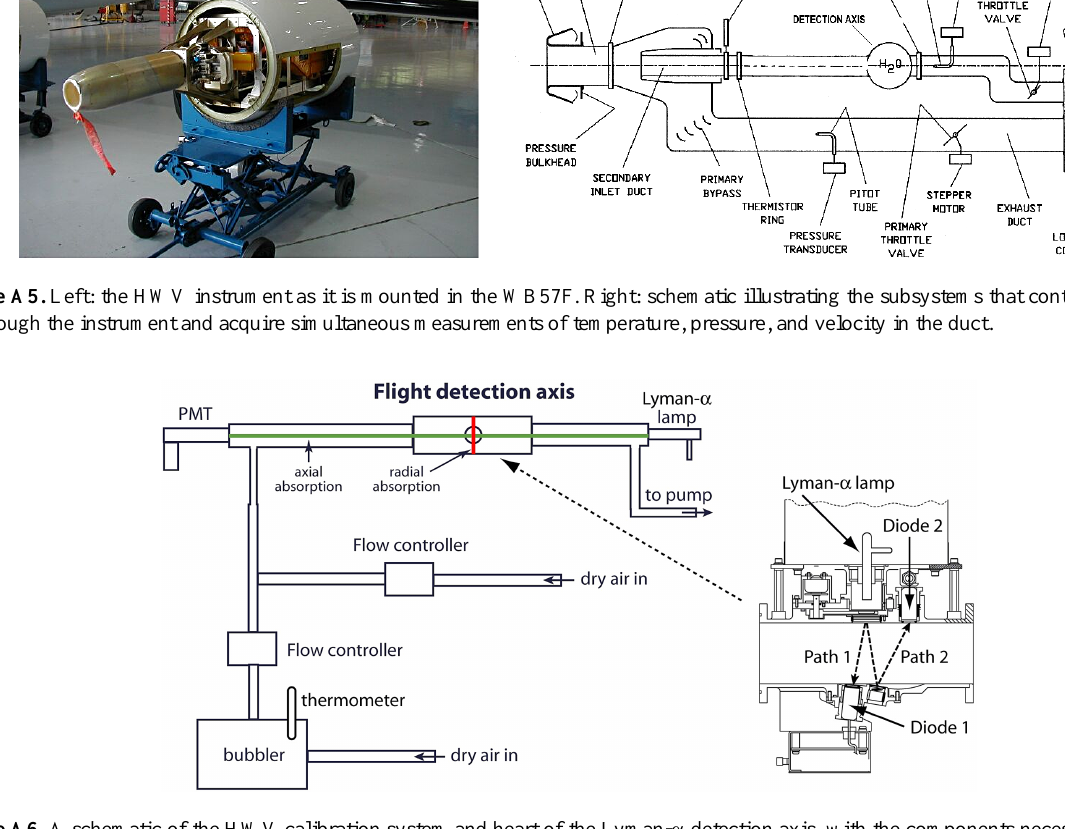
Figure A6. A schematic of the HWV calibration system and heart of the Lyman- α detection axis, with the components necessary for radial absorption labeled. The calibration system is routinely used in the laboratory and in the field. The bubbler serves as both a water vapor source and a primary standard. In the laboratory, axial absorption of 121.6nm light down the 1m length of the duct is a secondary reference standard. Radial absorption of 121.6nm light provides independent verification of the fluorescence measurement accuracy in